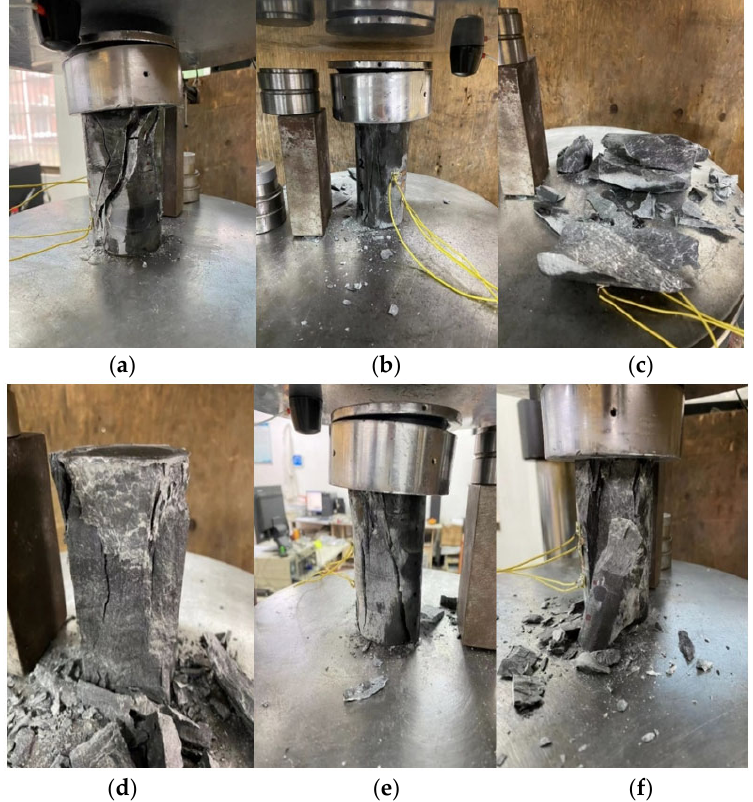
Figure 8. Failure mode of rock uniaxial graded cyclic loading and unloading test. ( a ) B01; ( b ) B02; ( c ) B03; ( d ) B04; ( e ) B05; ( f ) B06.